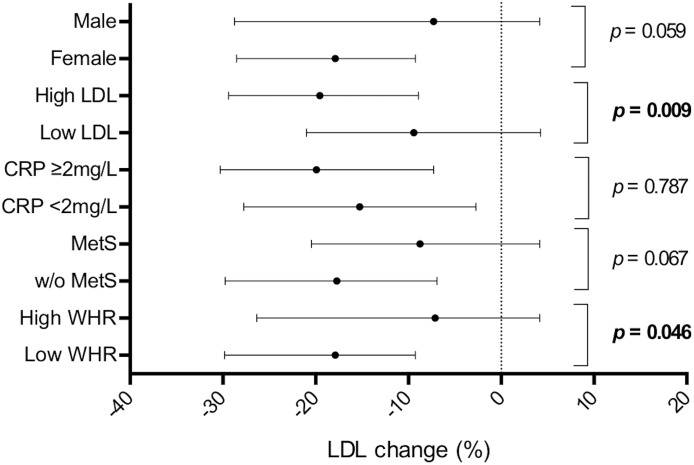
Low density lipoprotein reduction in different subgroups. LDL reduction is shown as median and interquartile range. P-values refer to the difference in the subgroups shown on the left. CRP, c-reactive protein; MetS, metabolic syndrome; WHR, waist-hip ratio.